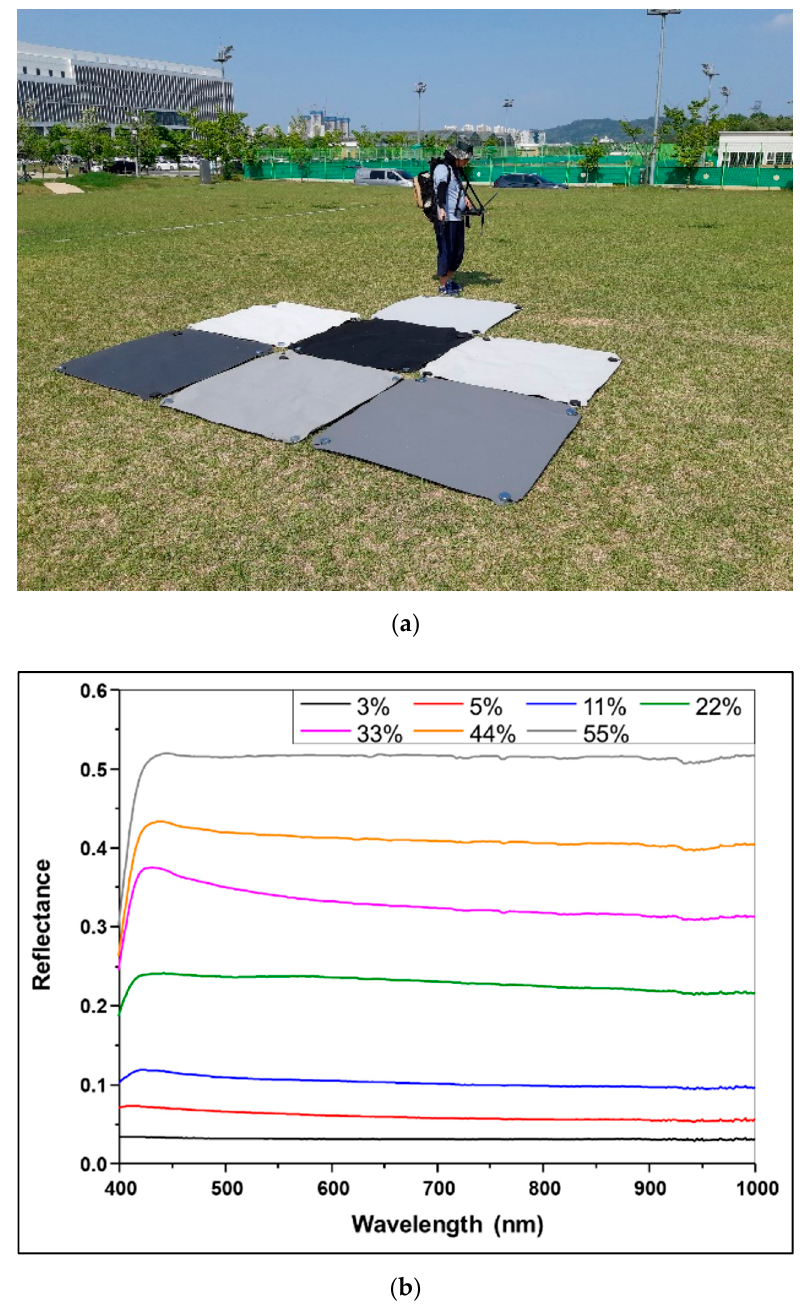
Figure 3. ( a ) Ground reference panels installed for vicarious radiometric calibration of UAV images and ( b ) spectral reflectance measured using a spectro-radiometer.